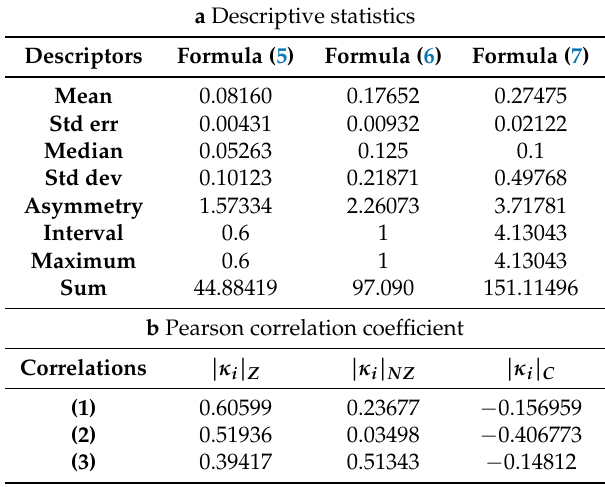
Table 1. Statistic analysis of Formulas